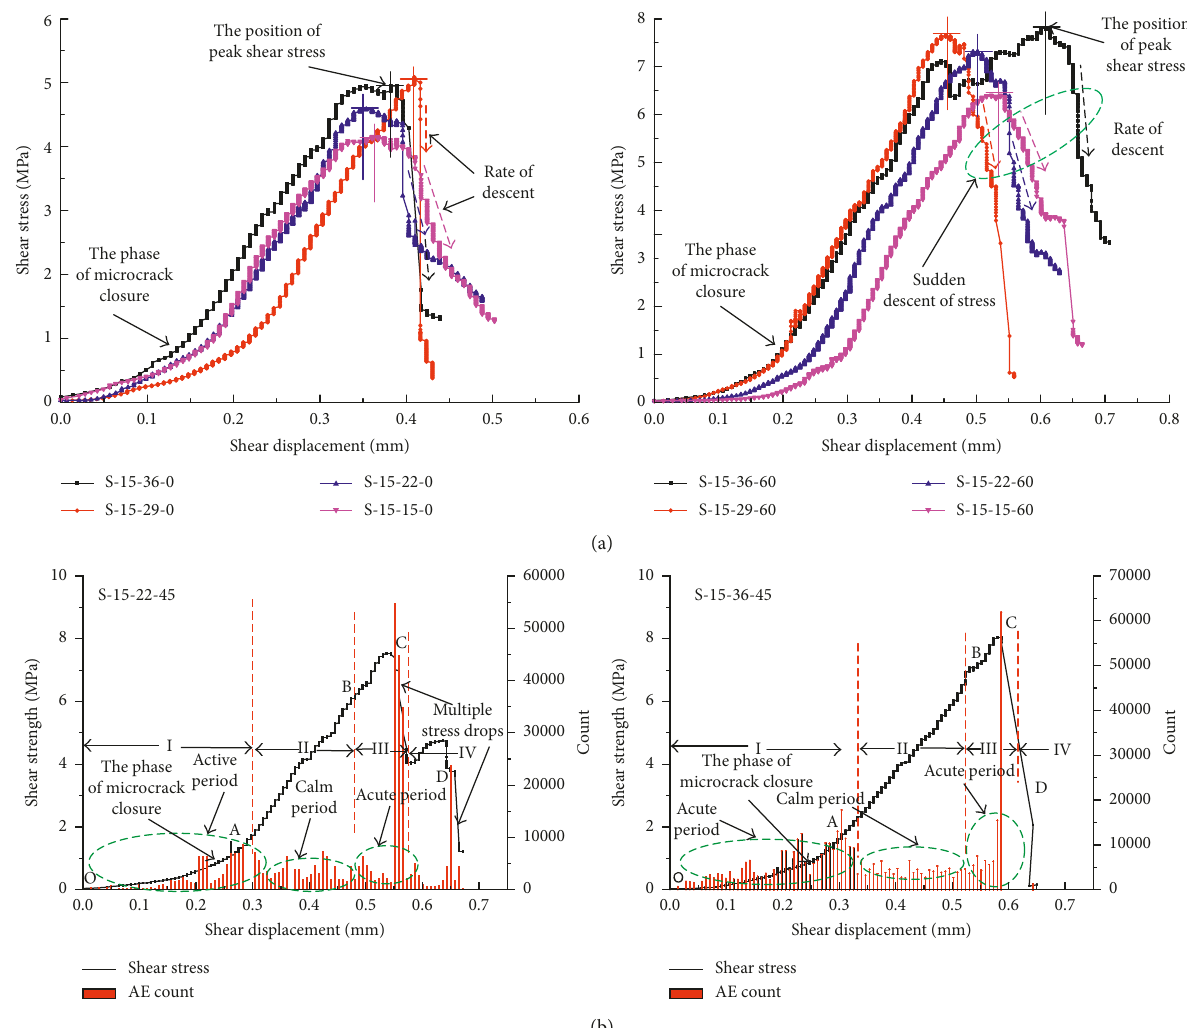
Figure 11: The effect of joint spacing on the shear stress-displacement curve and AE count: (a) the shear stress-shear displacement curves with the different joint spacing; (b) the variation of acoustic emission count for different spacing